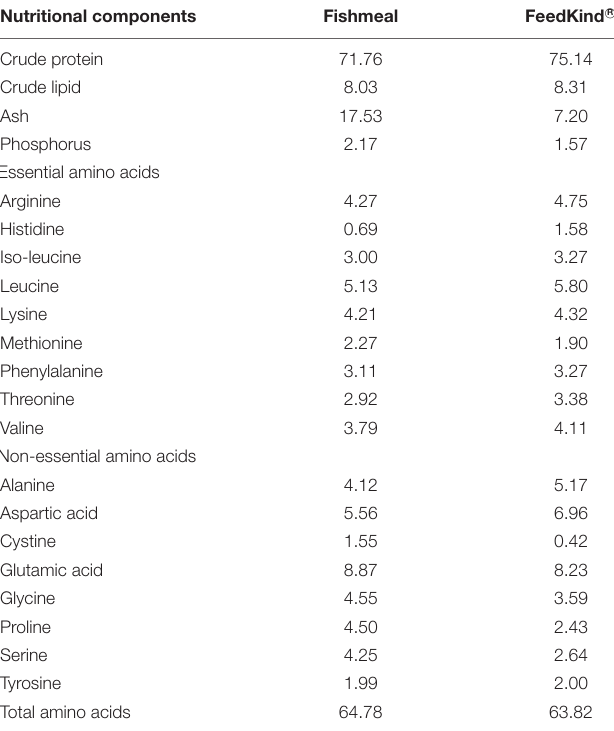
TABLE 1 | The nutritional composition of FeedKind R (cid:13) and fishmeal (%, dry matter). Nutritional components